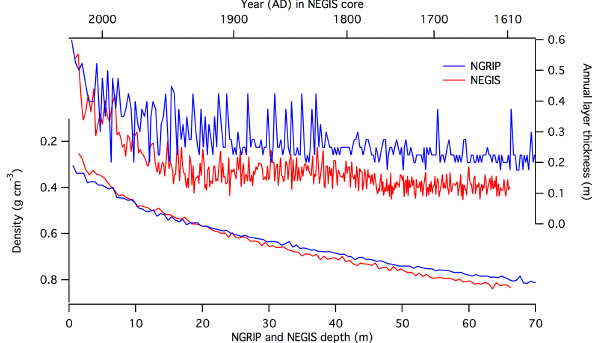
Figure 8. Annual layer thickness and density profiles for the NEGIS firn core and the upper 70m of the NGRIP ice